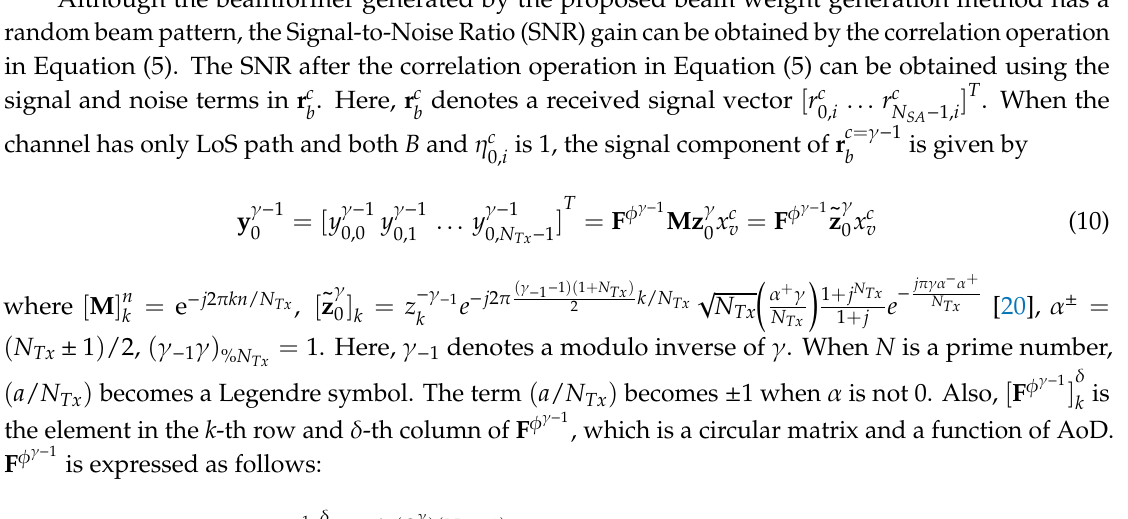
Figure 2. The procedure of the proposed CID and AoD estimation.